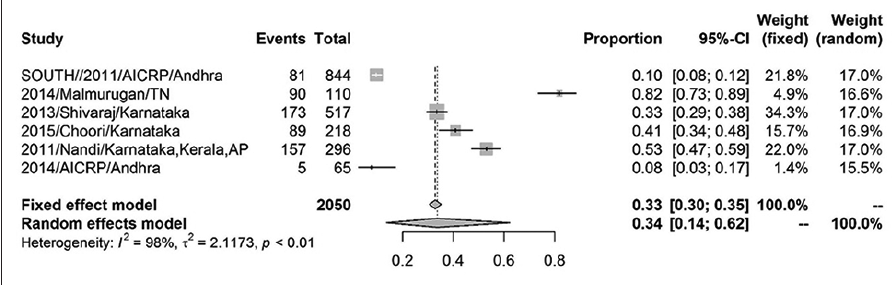
Figure-6: Forest plot of south zone classical swine fever